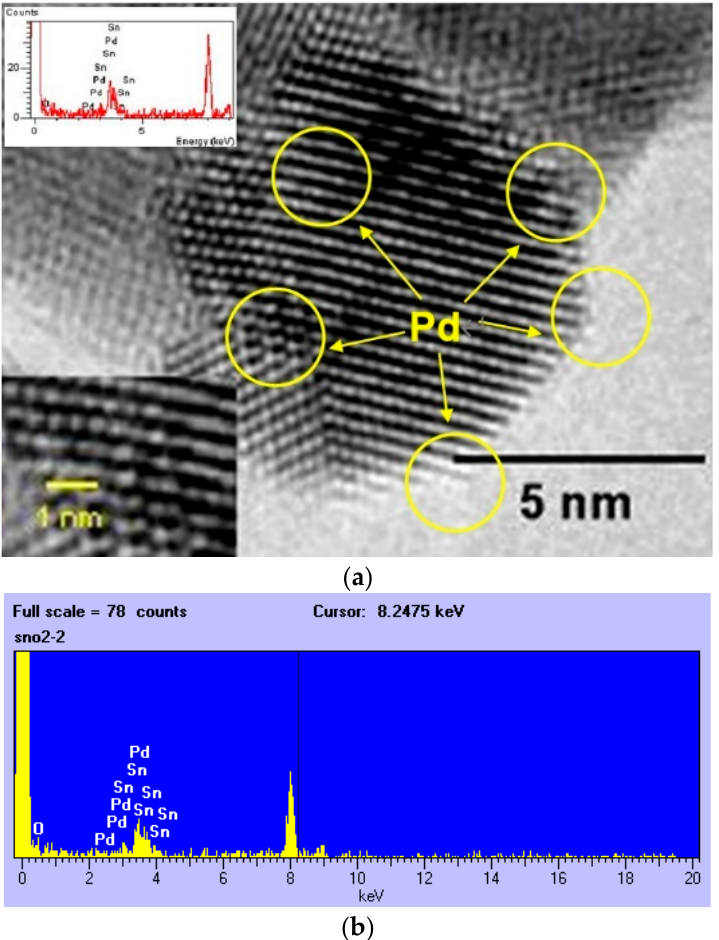
Figure 3. ( a ) HRTEM observation and ( b ) EDS analysis of SnO 2 -Pd NPs synthesized with in situ method (after heat-treatment at 300 ◦